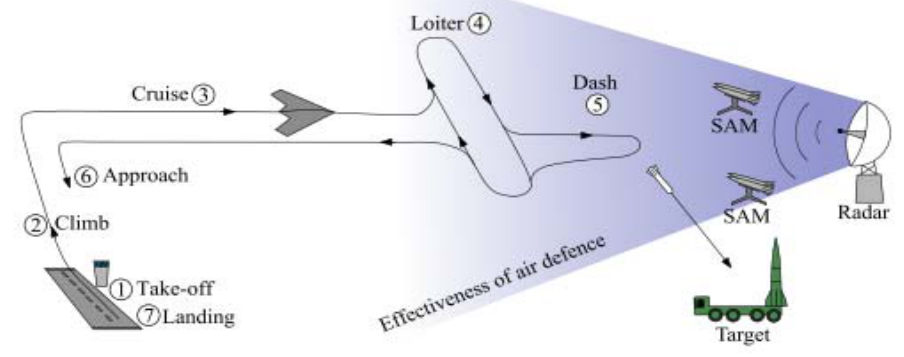
Figure 6. Typical Mission of SACCON